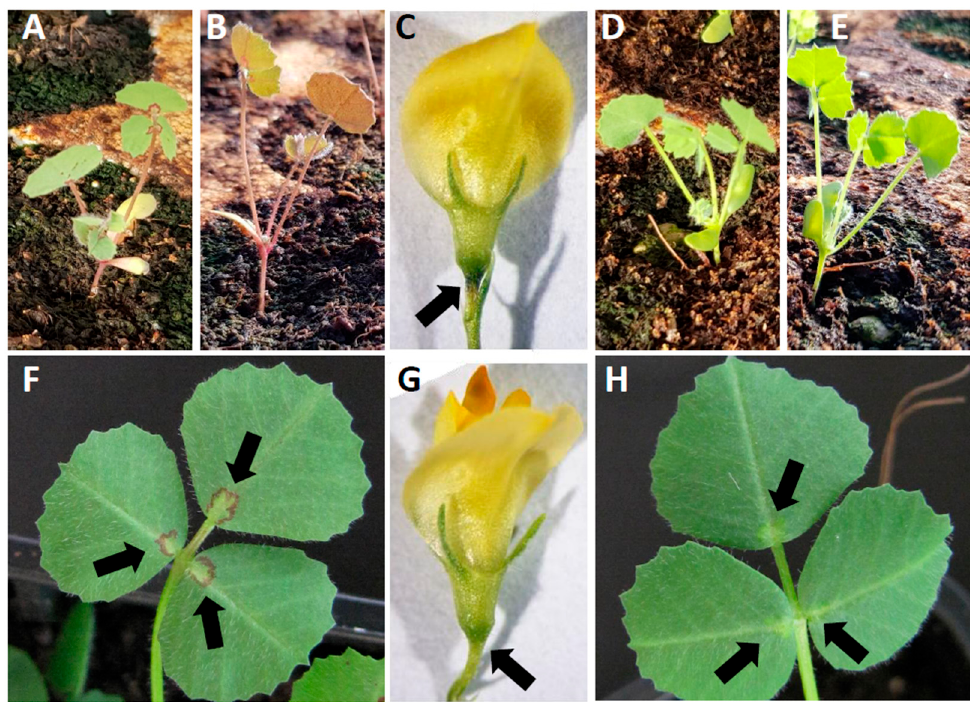
Figure 1. Pictures of wild -type plants ( A – C , F ) and R45 mutant line ( D , E , G , H ). Arrows in ( F , H ) point to the leaf blot ( F ) and to the corresponding position in R45 ( H ). Arrows in ( C , G ) point to the dark- ened region at the junction of pedicel and calyx ( C ) and to the corresponding position in R45 ( G ). Pictures ( A , B , D ) E were taken in a cold greenhouse where pigmentation in the aerial tissues was induced by low temperatures in the wild type ( A , B ), while no pigmentation was observable in R45 ( D , E ).